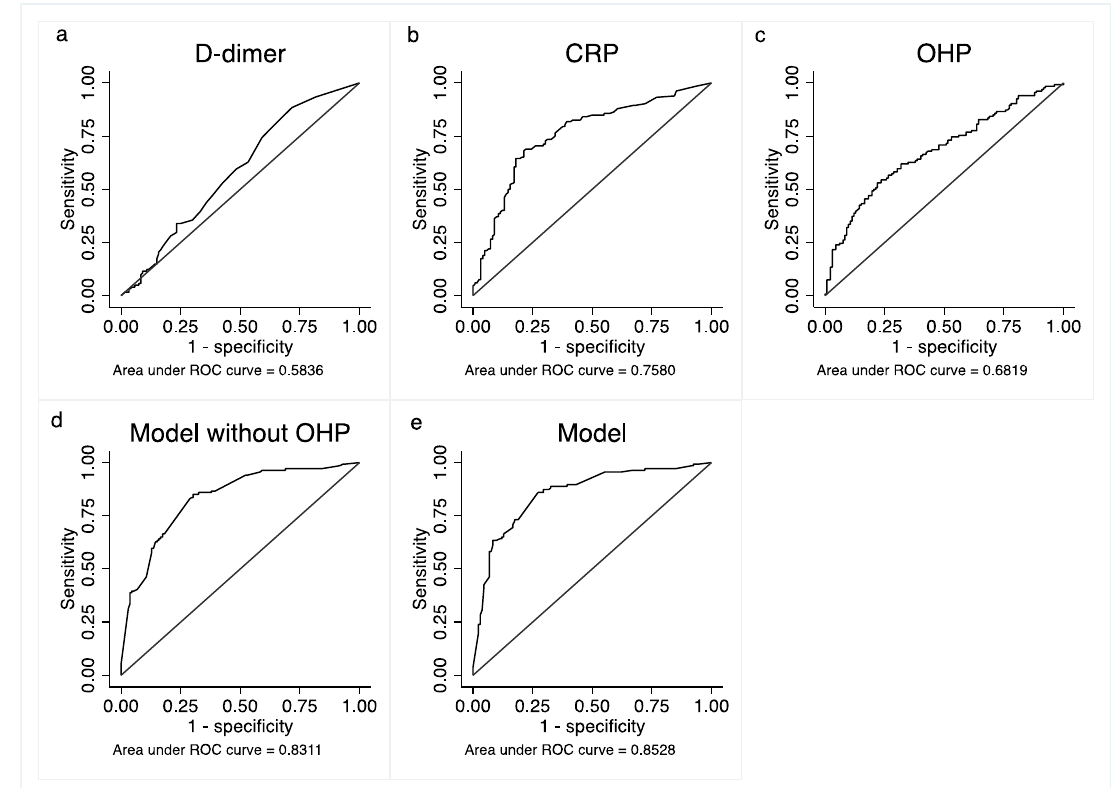
Figure 2. Receiver operating curves with outcome being oxygen requirement. (a) D-dimer (b) CRP; (c) OHP (d) multivariate model without OHP (e) multivariate model with OHP.